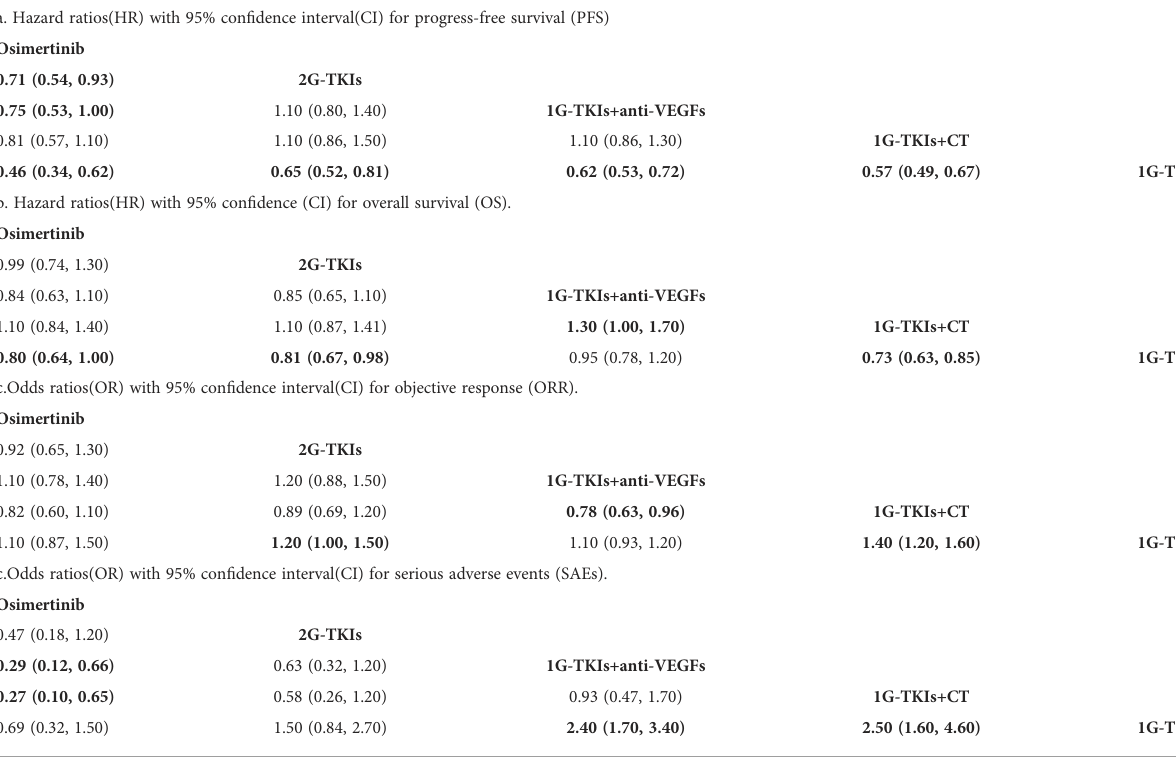
TABLE 3 Results of network meta-analysis for PFS, OS, ORR and